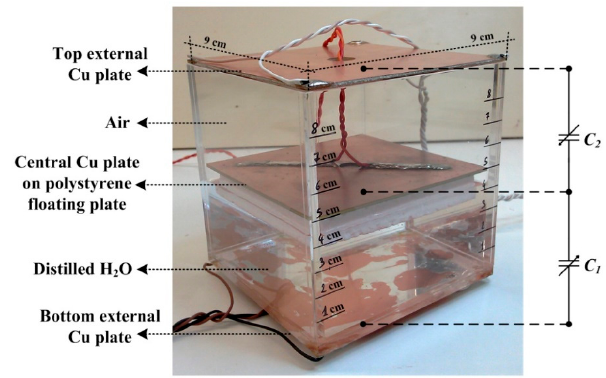
Figure 8. Developed liquid level meter employed as differential capacitive sensor. Electronics 2019 , 8 , x FOR PEER REVIEW